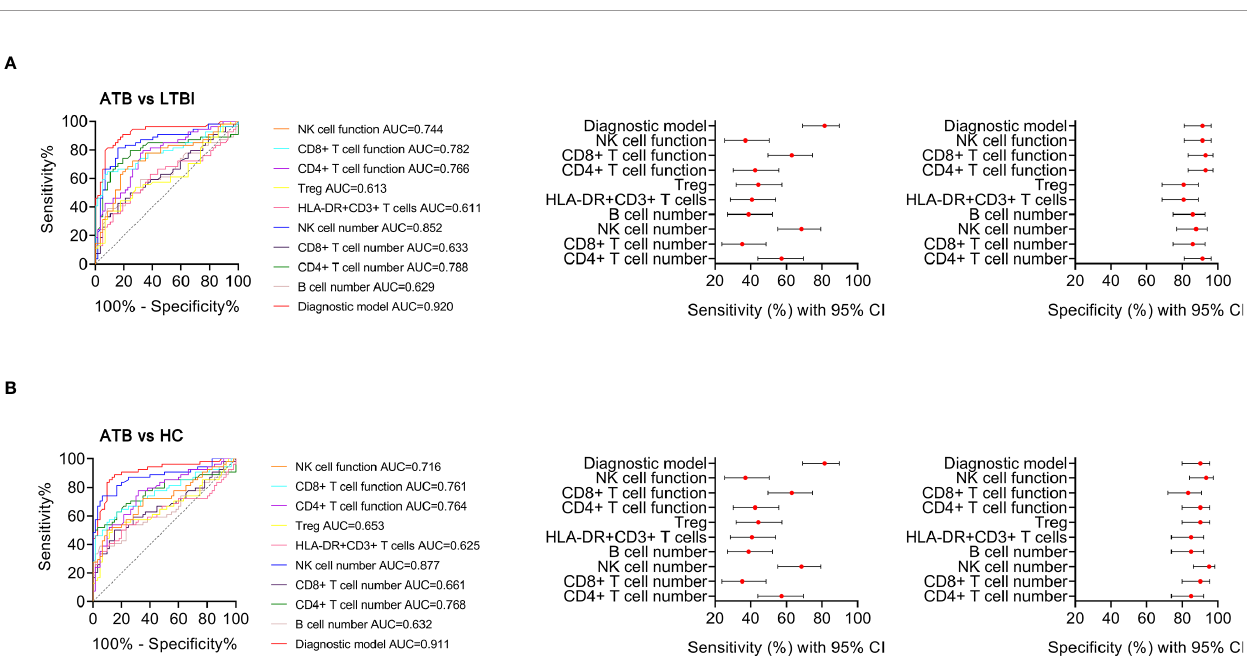
FIGURE 8 | The performance of various indicators in discriminating ATB from LTBI and HC. (A) ROC analysis showing the performance of various indicators in discriminating ATB patients from LTBI individuals. Liner plots showing the sensitivity and speci fi city of different indicators as well as their 95% CI. (B) ROC analysis showing the performance of various indicators in discriminating ATB patients from HC. Liner plots showing the sensitivity and speci fi city of different indicators as well as their 95% CI. ATB, active tuberculosis; LTBI, latent tuberculosis infection; HC, healthy controls; AUC, area under the curve; CI, con fi dence